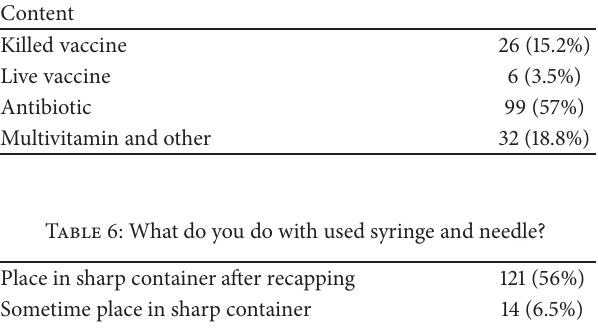
Table 3: Activity carried out during the last needlestick injury ( 𝑛 = 171 ).